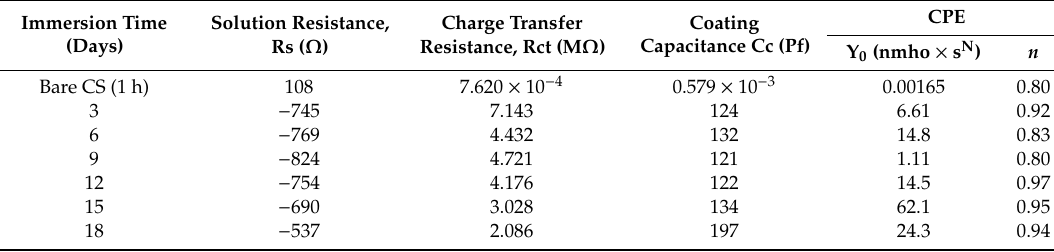
Table 4. The electrochemical parameters obtained from the impedance of CAPUOA / FS2 nanocomposite CS in the 3.5 wt.% NaCl solution at room